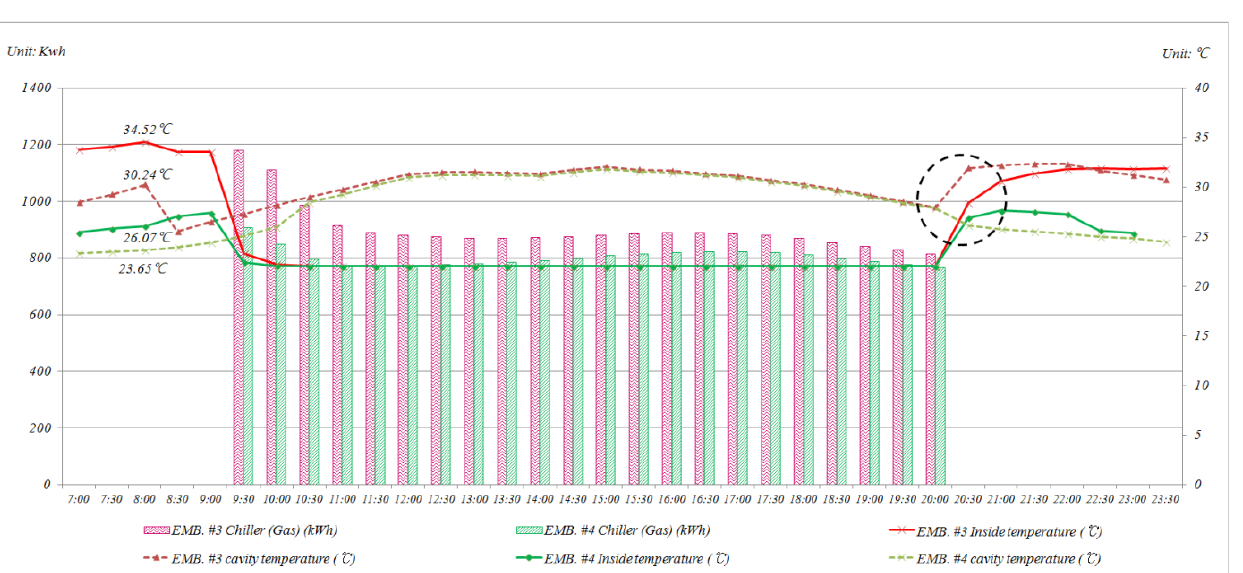
Figure 9. Temperature-time profile and cooling energy consumption on a summer day (EM #4 vs. EM B B